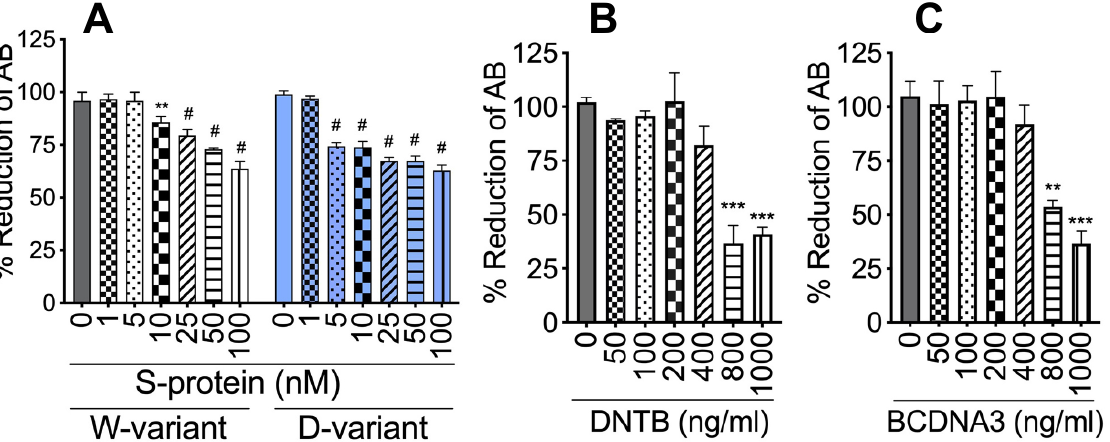
Figure 1. Cytotoxicity of S-proteins, rTFPI, and DTNB on HLMEC. HLMEC were treated with S-proteins ( A ), rTFPI ( B ), and DTNB ( C ) and cytotoxicity at 24 to 48 h assessed by AlamarBlue assay. ** p < 0.004; *** p < 0.0007; # p < 0.0001, compared to untreated controls.